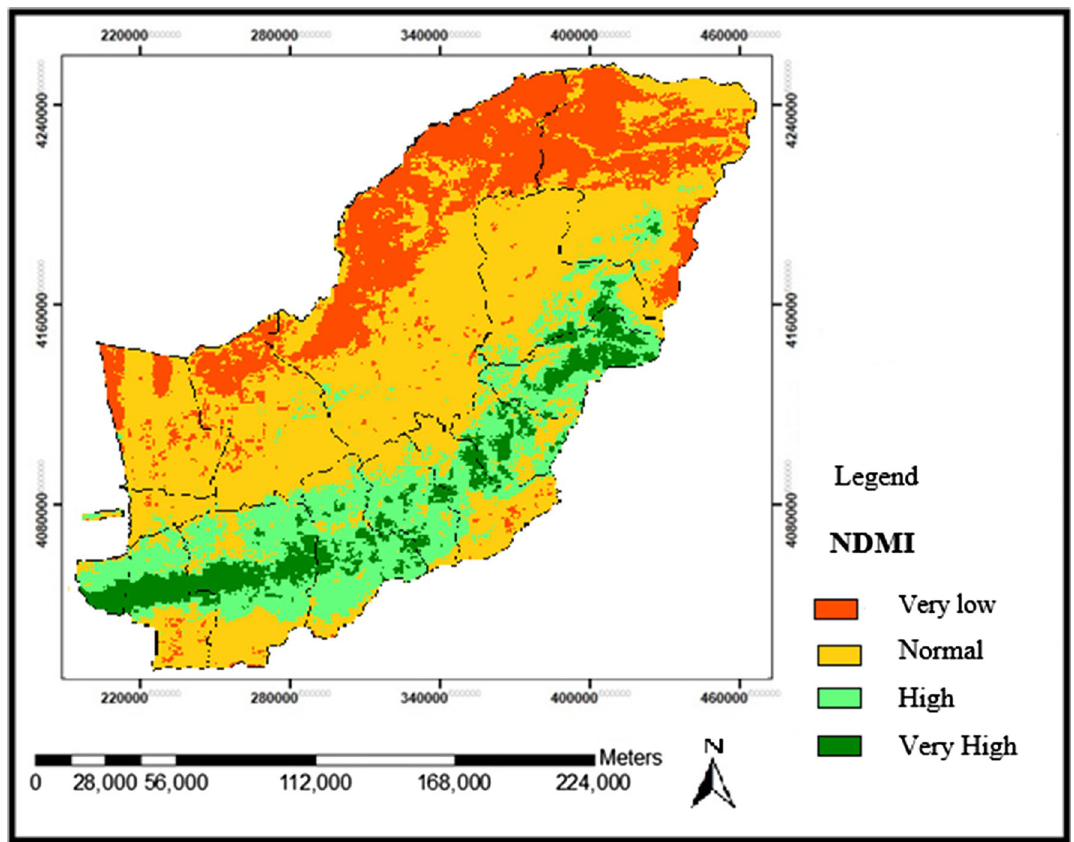
Fig. 6 NDMI of Golestan province in winter from 2005 to